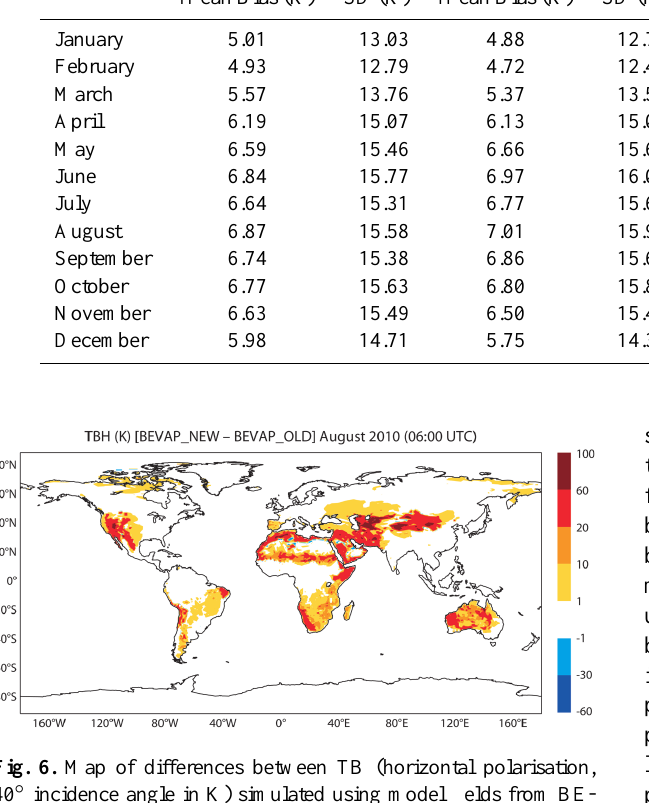
Table 5. Monthly mean statistics of the difference between simulated TB in BEVAP NEW and BEVAP OLD. Statistics are given for both horizontal and vertical polarizations, at 06:00UTC and 18:00UTC, based on 40 ◦ incidence angle simulated TB. TBH (BEVAP NEW) – TBH (BEVAP OLD) TBV (BEVAP NEW) – TBV (BEVAP OLD) 2010